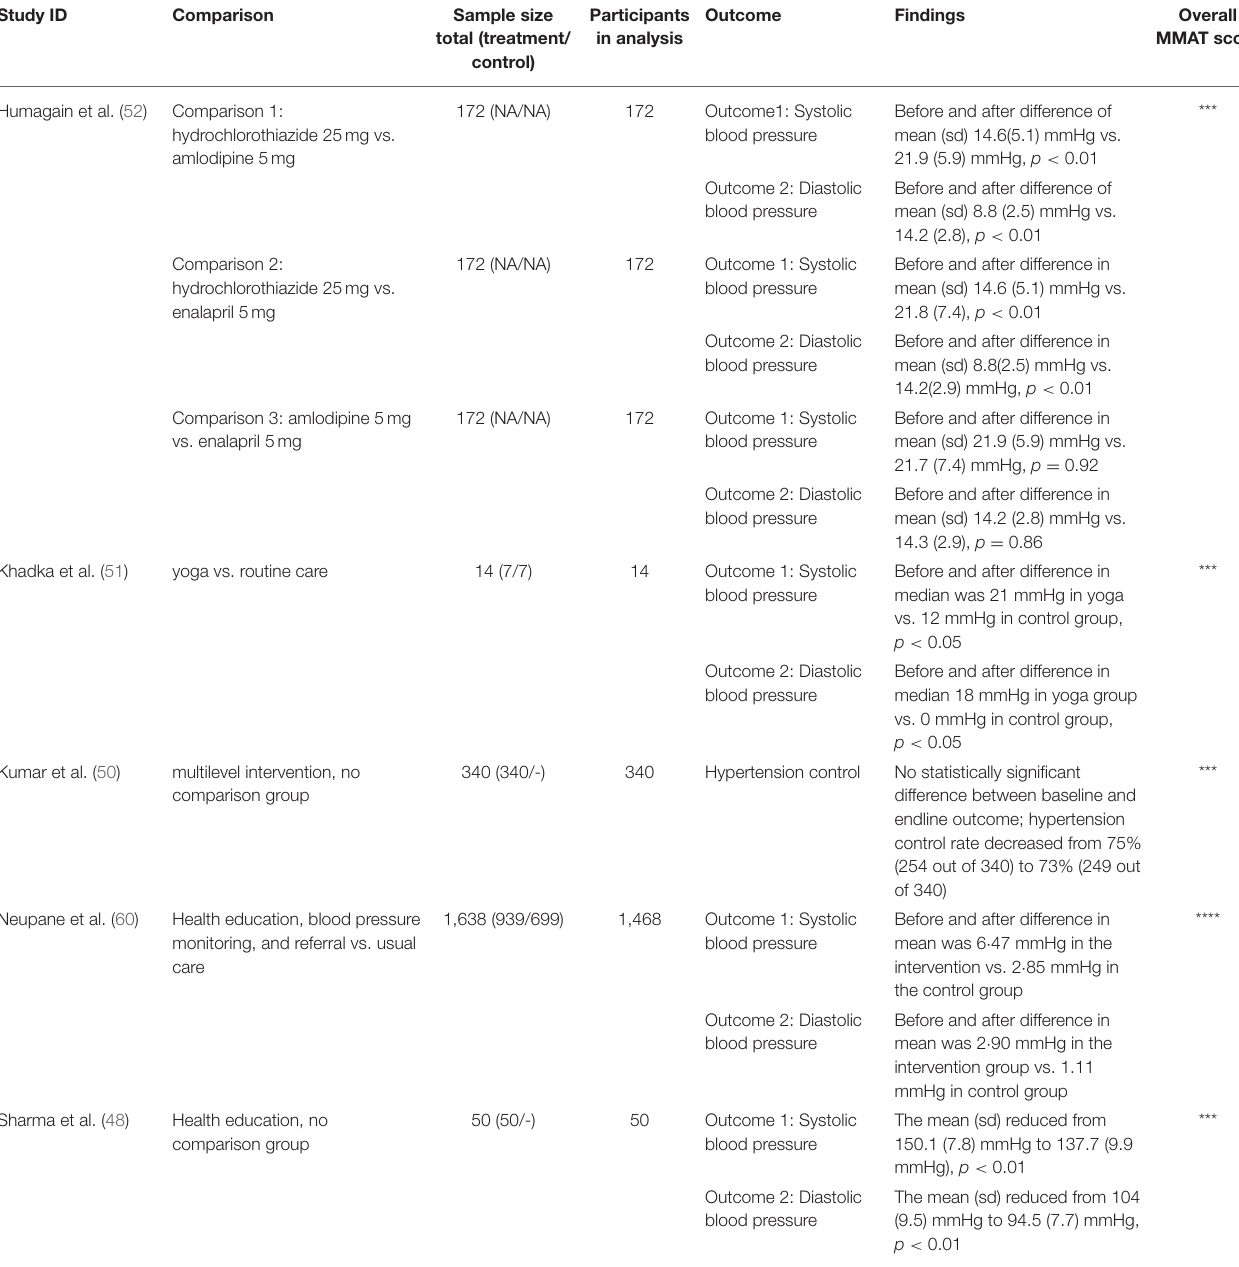
TABLE 3 | Findings of the studies on the effectiveness of strategies to improve hypertension treatment and control in Nepal. Study